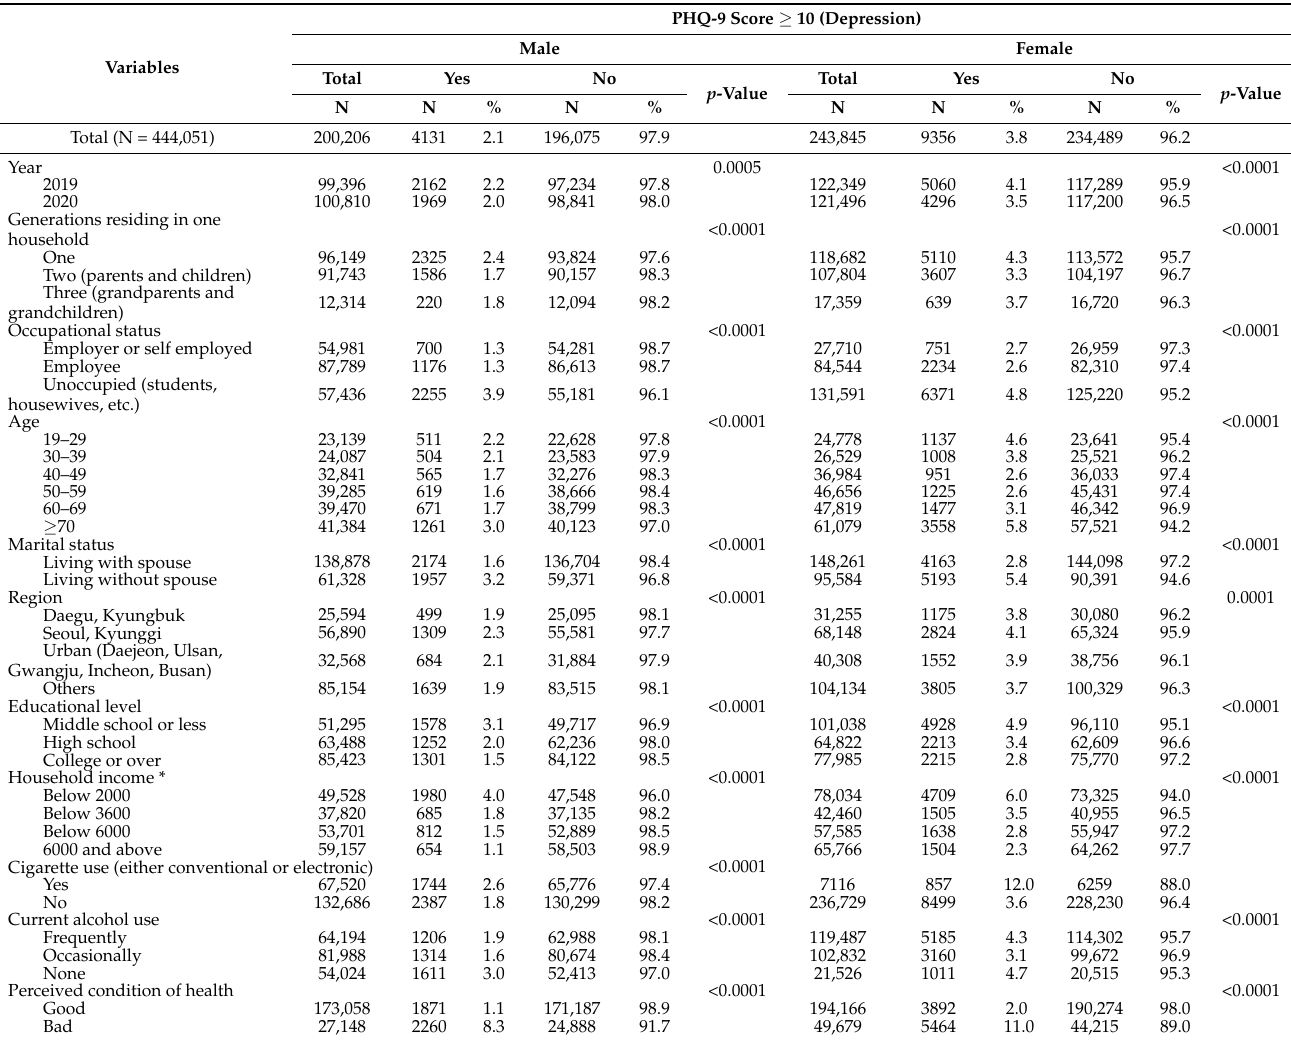
Table 1. General characteristics of the study